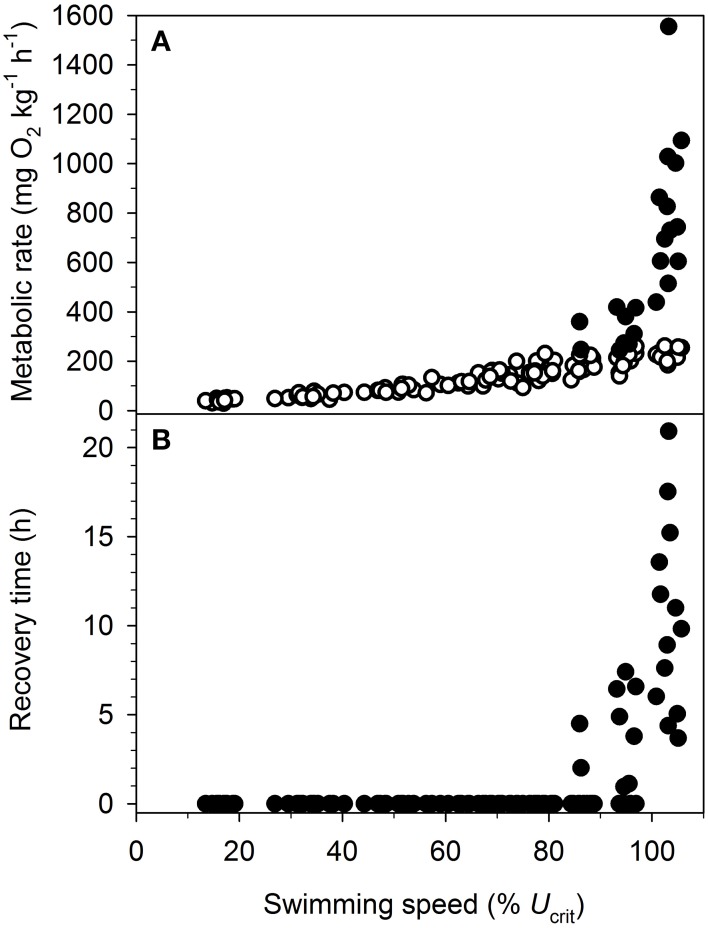
(A) Metabolic rate (mg O2 kg−1 h−1) and (B) recovery time (h) in relation to swimming speed (%Ucrit) in individual gilthead sea bream (Sparus aurata). Ucrit is the critical swimming speed and defined in detail in the text. For (A), metabolic rates were measured in the swimming fish (exercise MO2; open symbols) and as excess post exercise oxygen consumption (EPOC; mg O2 kg−1). Exercise MO2 and EPOC were combined to estimate the total metabolic cost of swimming (total MO2; closed symbols). For (B), recovery time (h) reflects the duration of EPOC after single swimming exercises (up to 30 min).